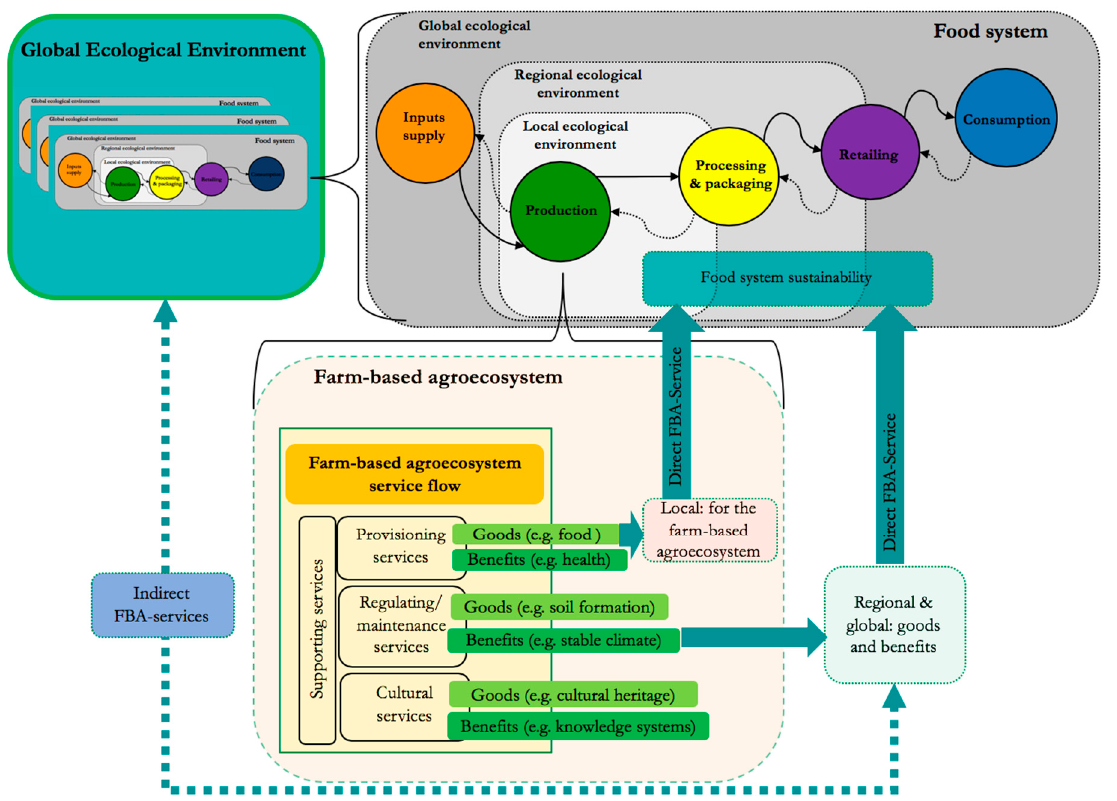
Figure 3. Conceptual model of a food system. Food systems are part of the global ecological environment, and their activities depend on it and shape it at the same time. Based on references [23,33– 35] .